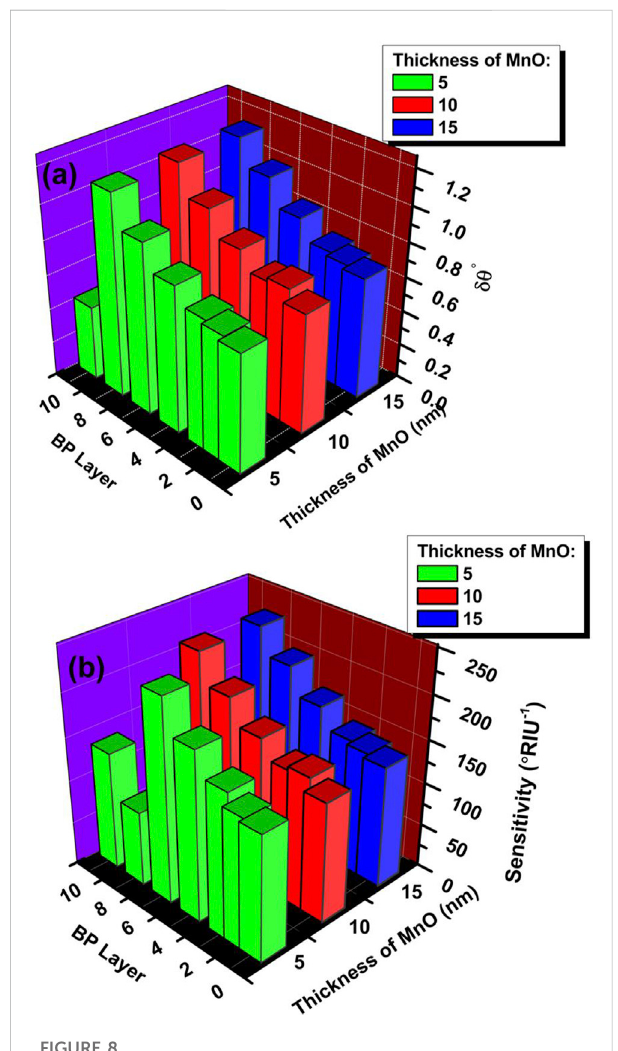
FIGURE 8 The variation of (A) de fl ection angle ( δθ ), (B) Sensitivity with the number of layers of BP for the three thicknesses 5 nm, 10 nm, and 15 nm of MgO.